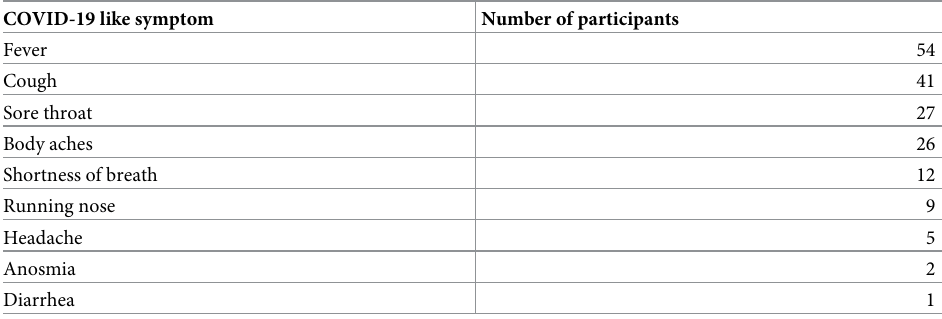
Table 3. COVID-19 like symptoms reported by study participants at the time of hospital visit (n =